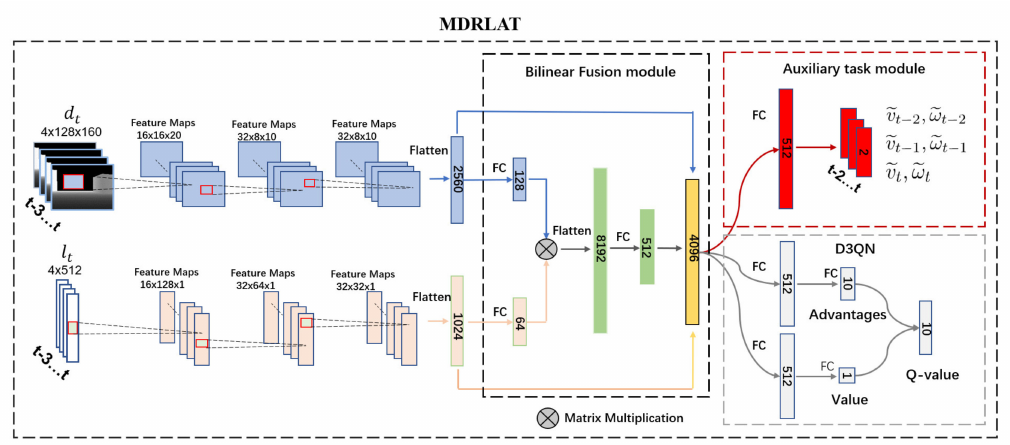
Figure 1. Network architecture of the proposed